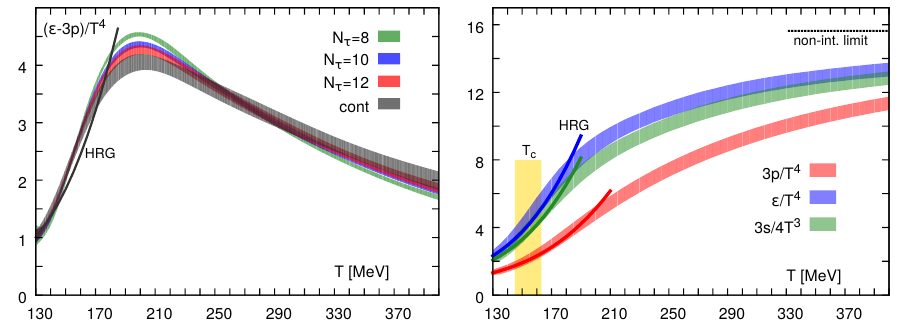
Figure 4. Left : The continuum-extrapolated trace anomaly for several values of the lattice spacing aT = 1/ N τ and its continuum extrapolation; Right : The continuum-extrapolated values of suitably normalized pressure, energy density, and entropy density as functions of the temperature. Both figures have been reproduced from Ref. [111]. The darker lines in both figures show the corresponding predictions of the hadron resonance gas (HRG)